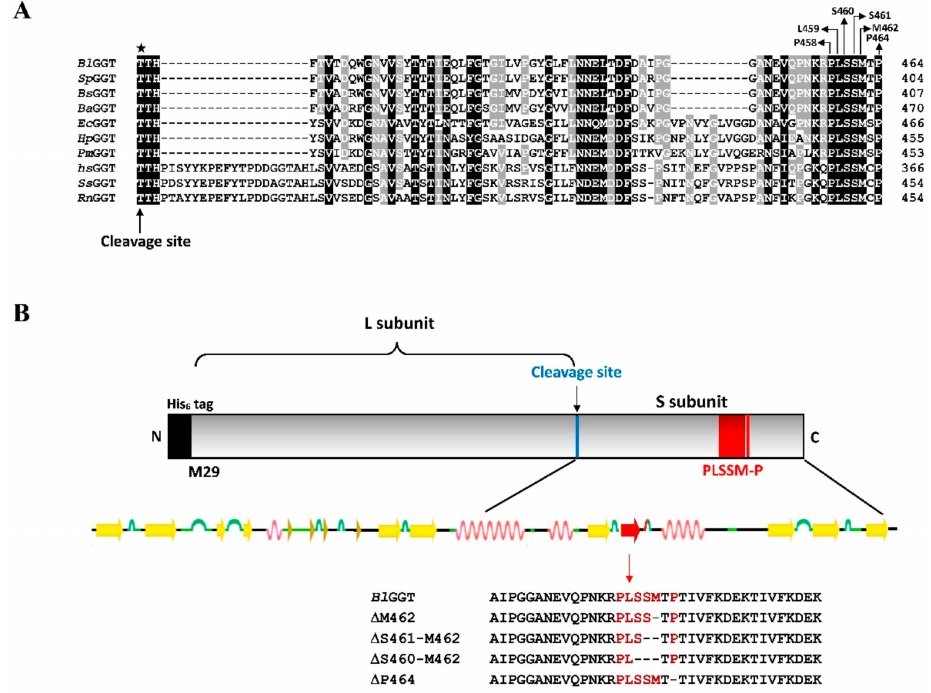
Figure 1. Multiple sequence alignment of γ -glutamyltranspeptidases (GGTs) from di ff erent organisms and schematic representation of deletion constructs. ( A ) The amino acid sequence of Bl GGT (UniProtKB-Q62WE3) is aligned with those of Streptococcus pneumoniae UniProtKB-A0A0U0D9D2), B.subtilis (UniProtKB-P54422), Bacillusamyloliquefaciens (UniProtKB-F4ELE6), E.coli (UniProtKB-P18956), H. pylori (UniProtKB-O25743), Proteus mirabilis (UniProtKB-B4EUO9), H. sapiens (UniProtKB-P19440), Sus scrofa (UniProtKB-P20735), and Rattus norvegicus (UniProtKB-P07314). The conserved catalytic